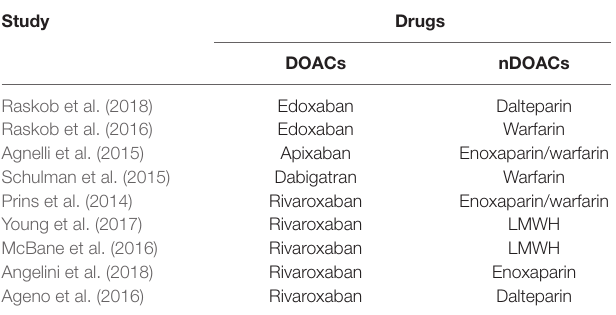
TABLE 4 | The drugs used in the assessed